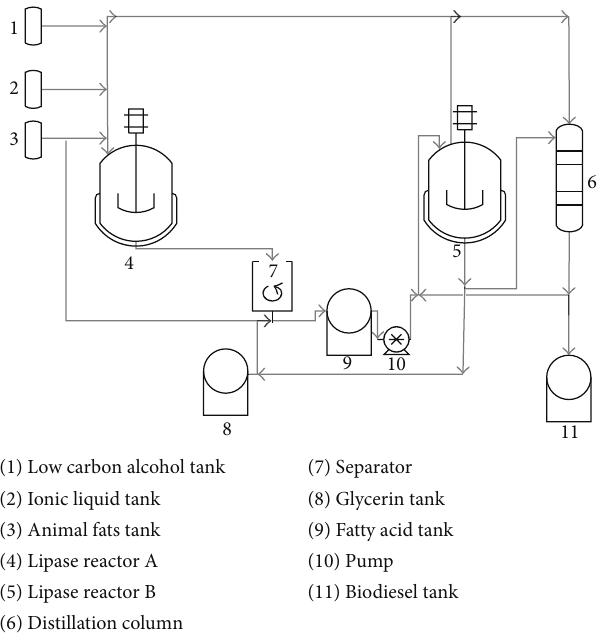
Figure 1: Process of producing biodiesel catalyzed by Limczyme in [BMIM][PF 6